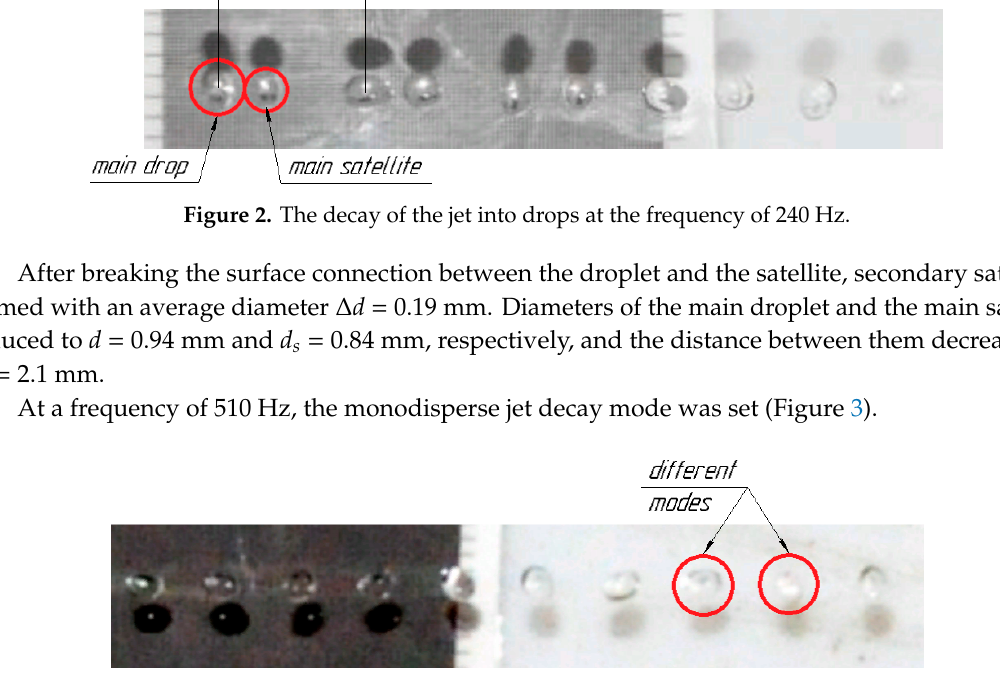
Figure 4. Secondary satellite formation at the frequency of 800 Hz.